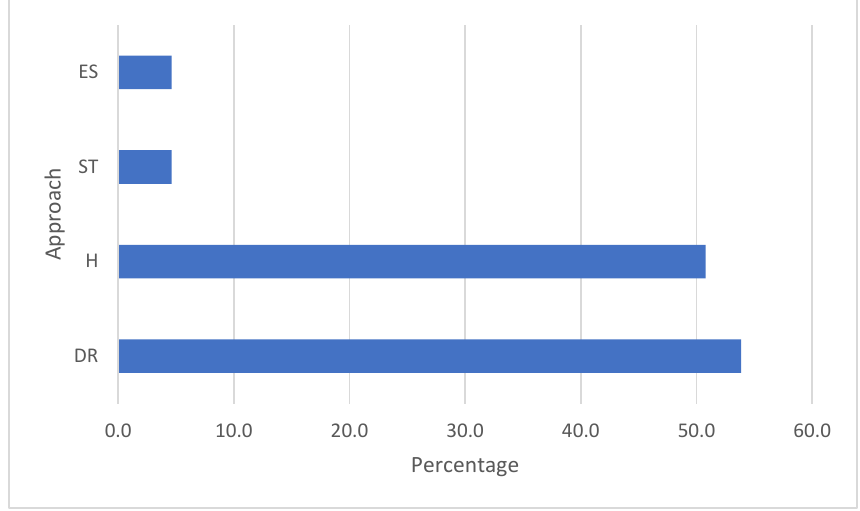
Fig. 3. Percentage of addressed problems with respect to approach